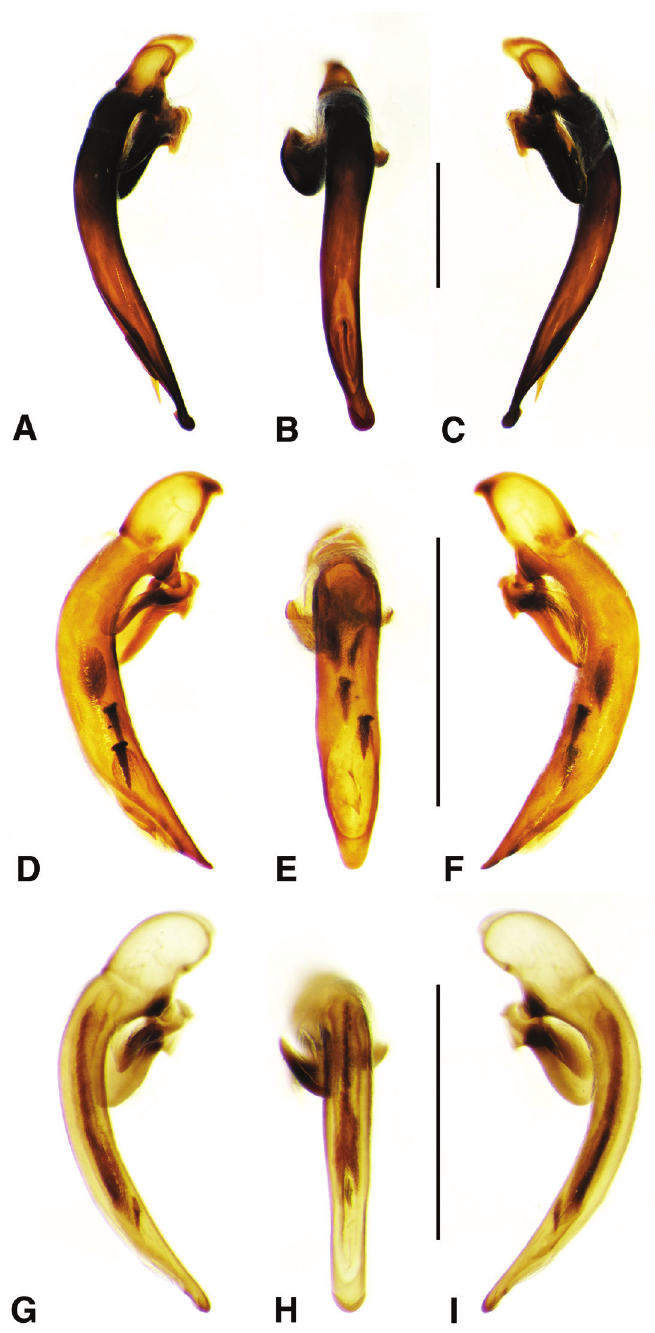
Figure 6. Digital images of male genitalia of Amblygnathus species. A, D, G right lateral aspect B, E, H dorsal aspect C, F, I left lateral aspect. A–C A. cephalotes Dejean D–F A. puncticollis (Putzeys) G–I A. gilvipes gilvipes Ball & Maddison. Scale bars 1